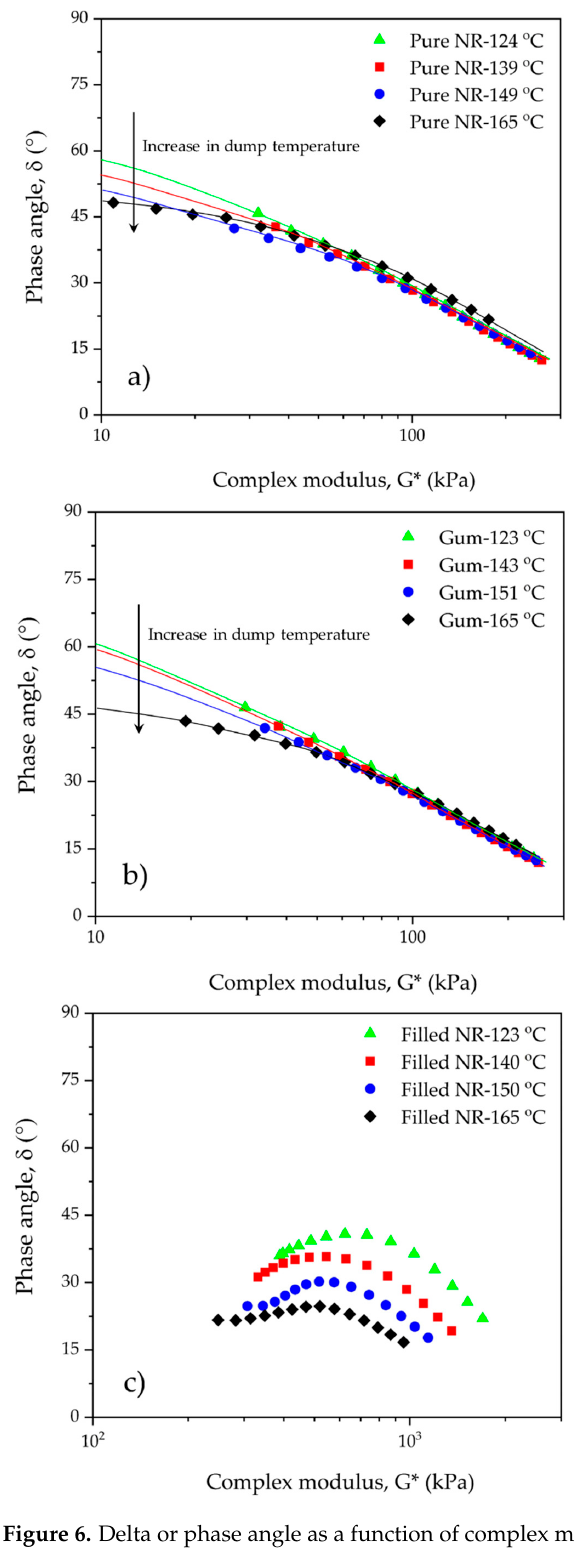
Figure 5. Delta or viscoelastic phase angle as a function of frequency for the pure ( a ), gum ( b ), and filled NR ( c ) compounds subjected to different dump temperatures.